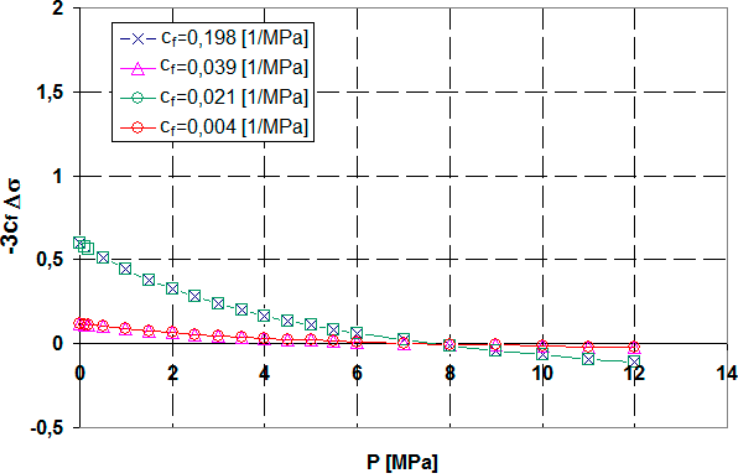
Figure 8. Deformations in Mannville Group coal produced solely by desorption based on the Cui and Bustin model.